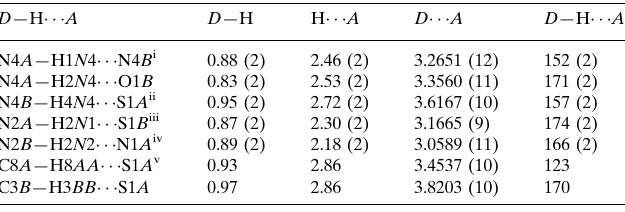
Hydrogen-bond geometry (A˚ , (cid:2)